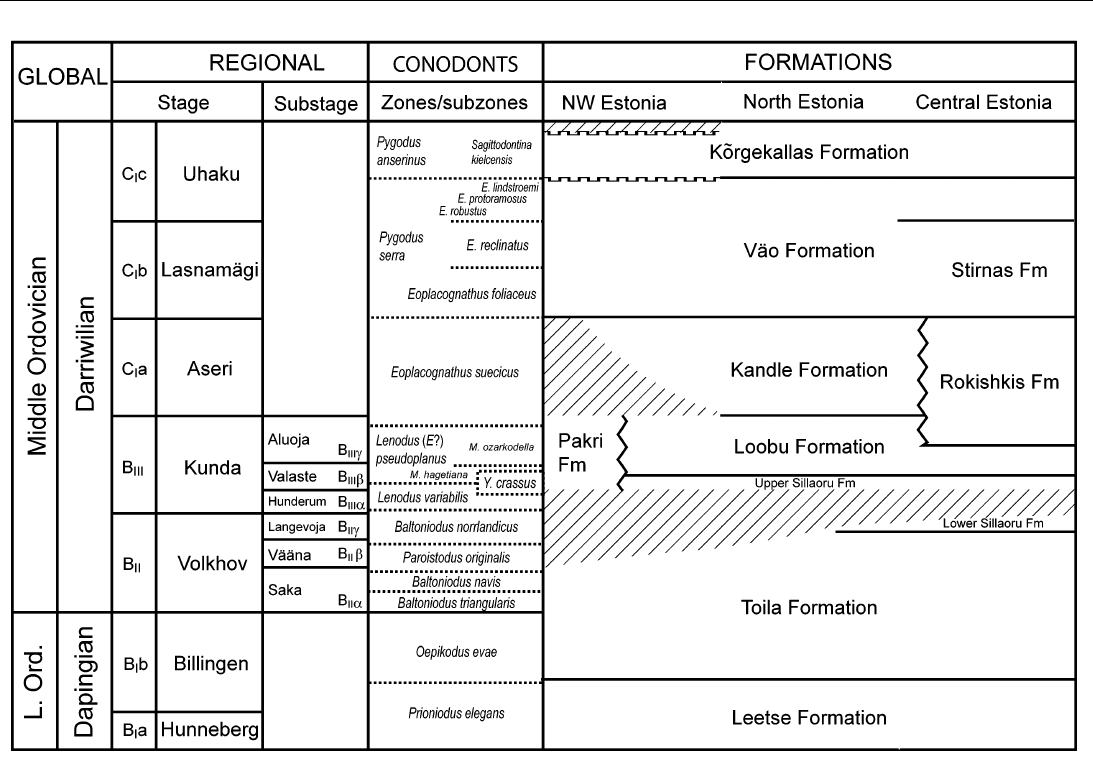
Fig. 2. Chrono-, bio- and lithostratigraphical chart of the upper part of the Lower Ordovician throughout the Middle Ordovician, correlating the global series and stages with the corresponding Baltoscandian units (left), conodont zones (middle) and the major formations of northwestern, northern and central Estonia (right). Stippled intervals denote missing strata. Dotted lines separating conodont zones indicate that boundaries are not fixed. Yangtzeplacognathus crassus (where present) is known to co-occur with both Lenodus variabilis and L. ( E. ?) pseudoplanus . After Bergstr(cid:246)m (1971), L(cid:246)fgren (1995, 2000), Zhang (1998a), Viira et al. (2001), Nılvak et al. (2006), Tinn et al. (2006), Mellgren & Eriksson (2010). Abbreviated genera: E . = Eoplacognathus , M . = Microzarkodina , Y . = Yangtzeplacognathus